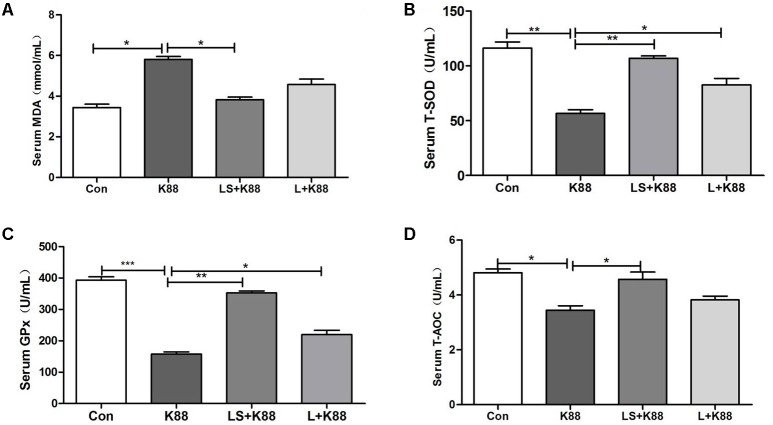
Effects of L. casei 393 and L. casei 393-SeNPs on oxidative stress in mice challenged by ETEC K88. Serum MDA (A), T-SOD (B), GPx (C), and T-AOC (D) levels in male C57BL/6 mice were measured by corresponding kits. Data represent mean ± SEM (n = 8), ∗P < 0.05, ∗∗P < 0.01, ∗∗∗P < 0.001. K88 means the rats orally administrated with ETEC K88 only. LS + K88 means the rats pretreated with L. casei 393 before administration with ETEC K88. LS means the rats treated with L. casei 393 only. MDA, malondialdehyde; GPx, glutathione peroxidase; T-SOD, total superoxide dismutase; T-AOC, total antioxidant capacity.